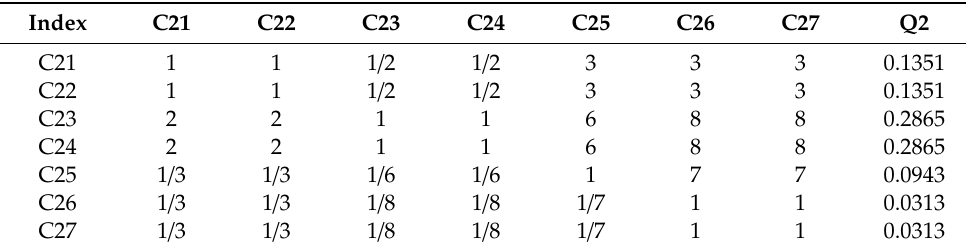
Table 4. Subjective weight of the electrical